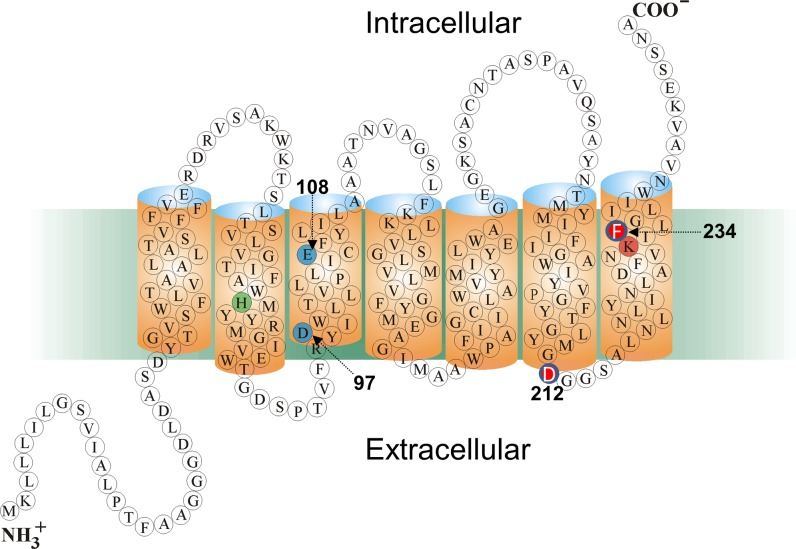
Predicted 2D folding pattern of GPR in bilayer membrane along with key residues in sequence.Sequence numbering given is for the Monterey Bay eBAC31A08 variant of GPR. The key carboxylate groups Asp97 and Glu108 (blue), Schiff base-forming residue Lys231 (orange) and His75 (green) are highlighted. The two residues Asp212 and Phe234 which are substituted with an Asn and Ser, respectively, to form GPR-DNFS are shown in red with white lettering. Reprinted in modified form from [22] under a CC BY license, with permission from the American Society for Biochemistry and Molecular Biology.